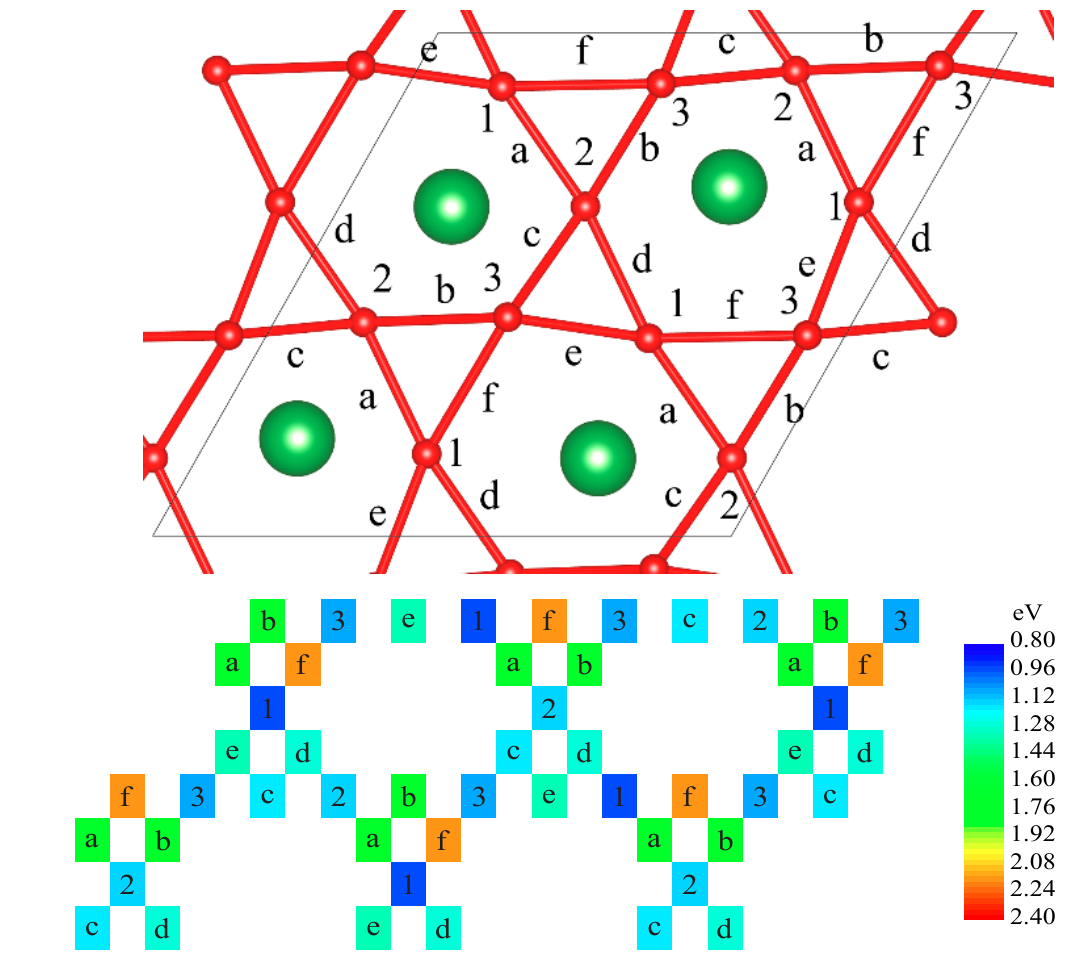
Figure 4. Oxygen vacancy formation energy (numbers) and transition states (letters) within the (011) interface, relative to the ideal interface and 1/2O 2 (Equation (2)) (Figure 1d). ( a ) Indexed crystal structure and ( b ) schematic view with coloured energy states, relative to the ideal interface and 1/2O 2 . Table 6. Oxygen vacancy formation energy, as in Figure 4. Numbered stable states (Equation (2)) and activation (Equation (3)) energy, in eV.